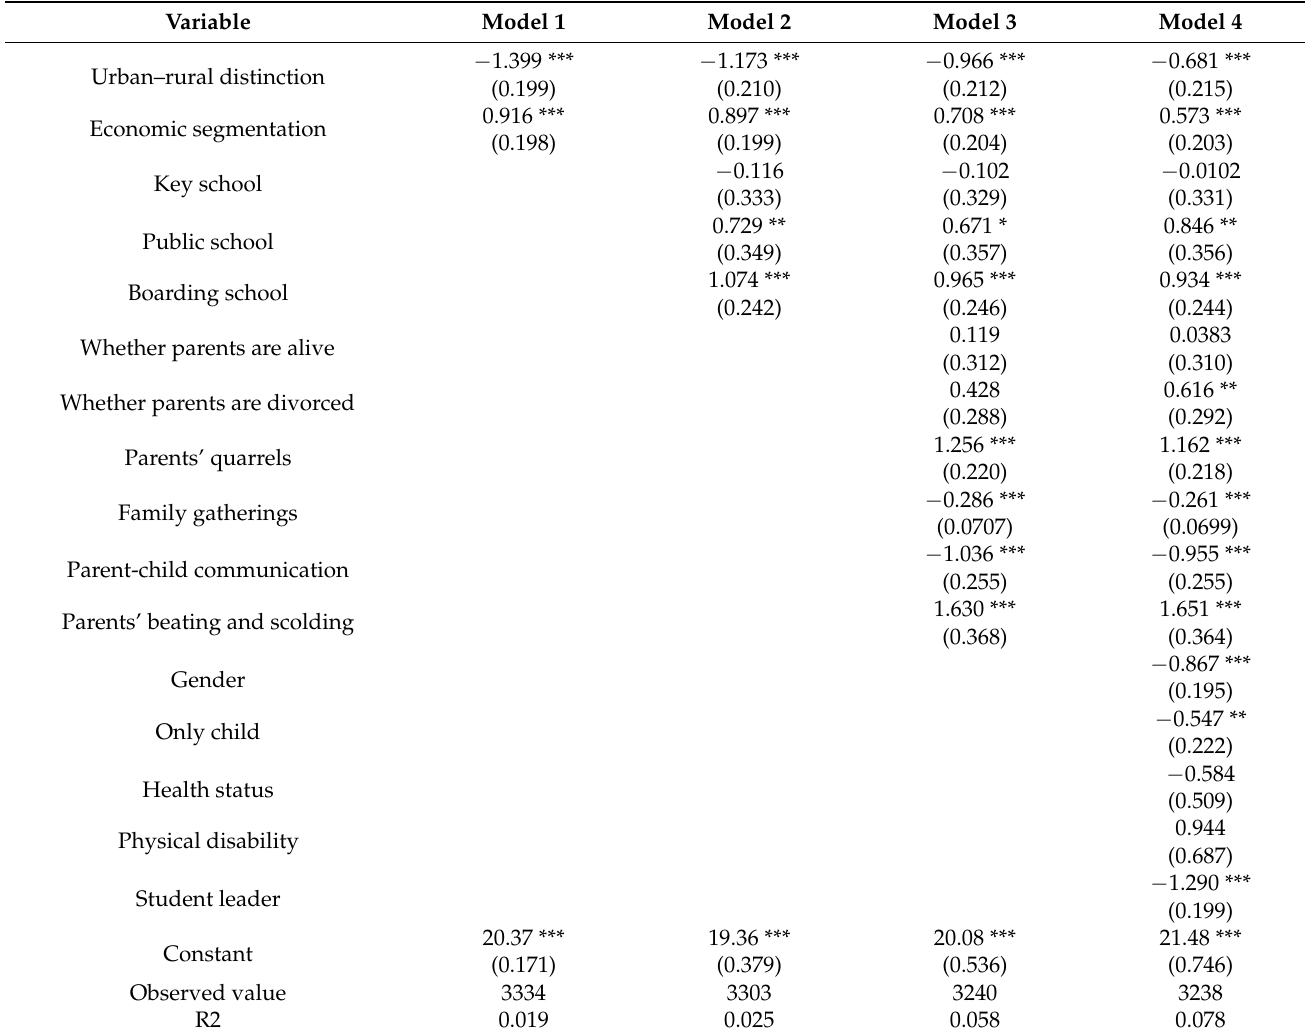
Table 2. Analysis results of the multiple regression